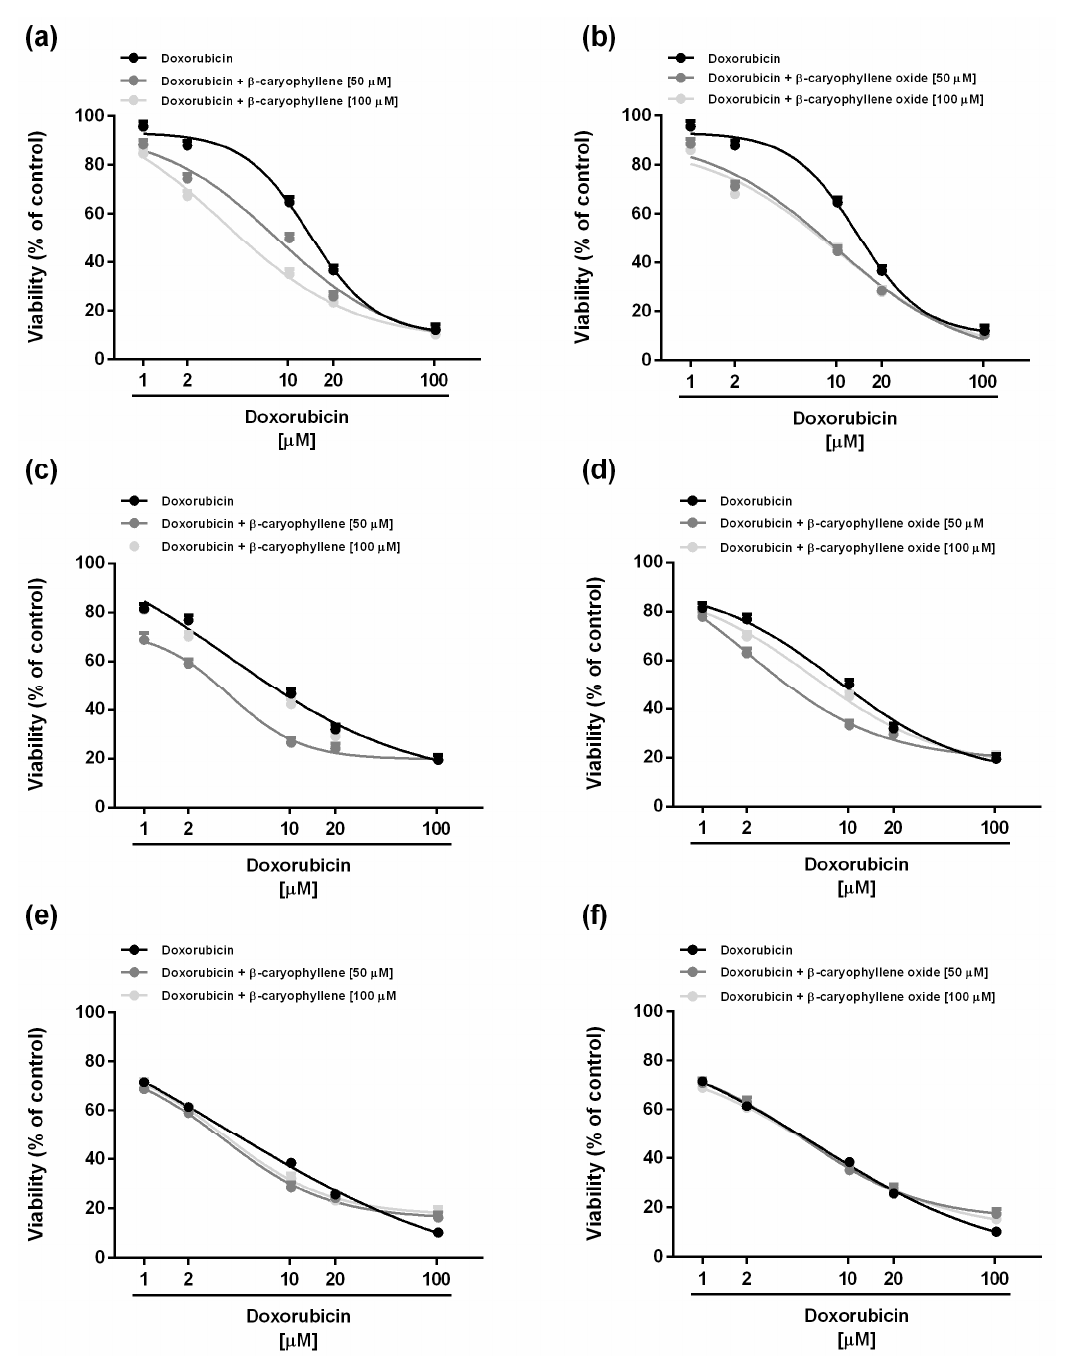
Figure 3. Cytotoxicity of doxorubicin in combination with the sesquiterpenes β -caryophyllene ( a , c , e ) and β -caryophyllene oxide ( b , d , f ) after metronomic exposures in HepG2 cells. ( a , b ) Single short exposure of 2 h. ( c , d ) Double repeated exposure of 2 h followed by a recovery time of 72 h. ( e , f ) Triple repeated exposure of 2 h followed by a recovery time of 72 h. Data represent the mean ± SE (standard error) of at least two experiments in which each treatment was tested in triplicate ( n = 6).